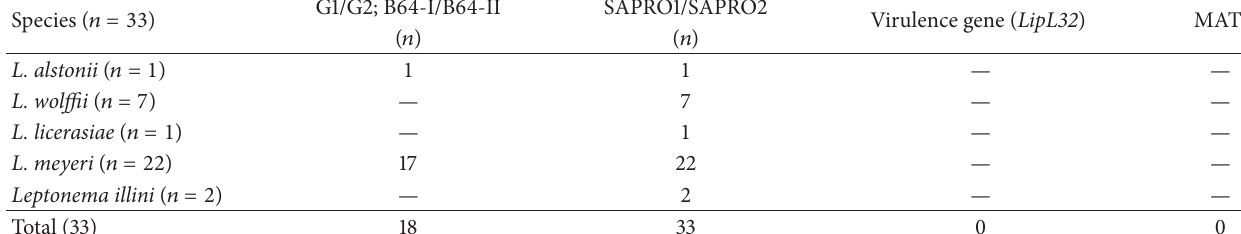
Table 2: Results for molecular and serological tests.